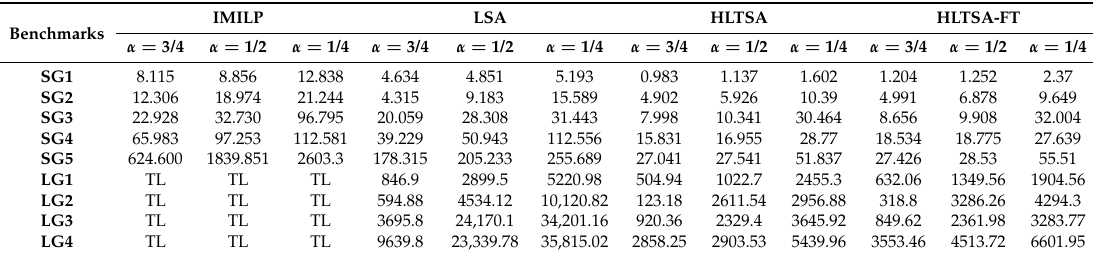
Table 6. Average computation time under different methods for various α .